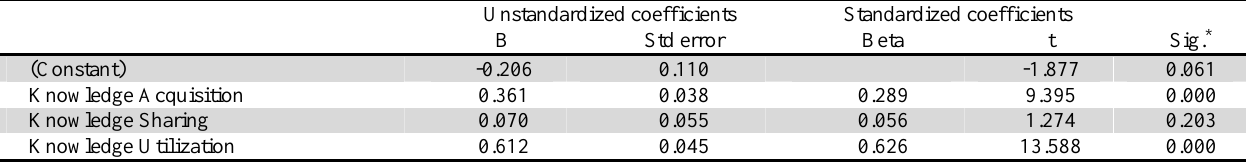
Knowledge Utilization